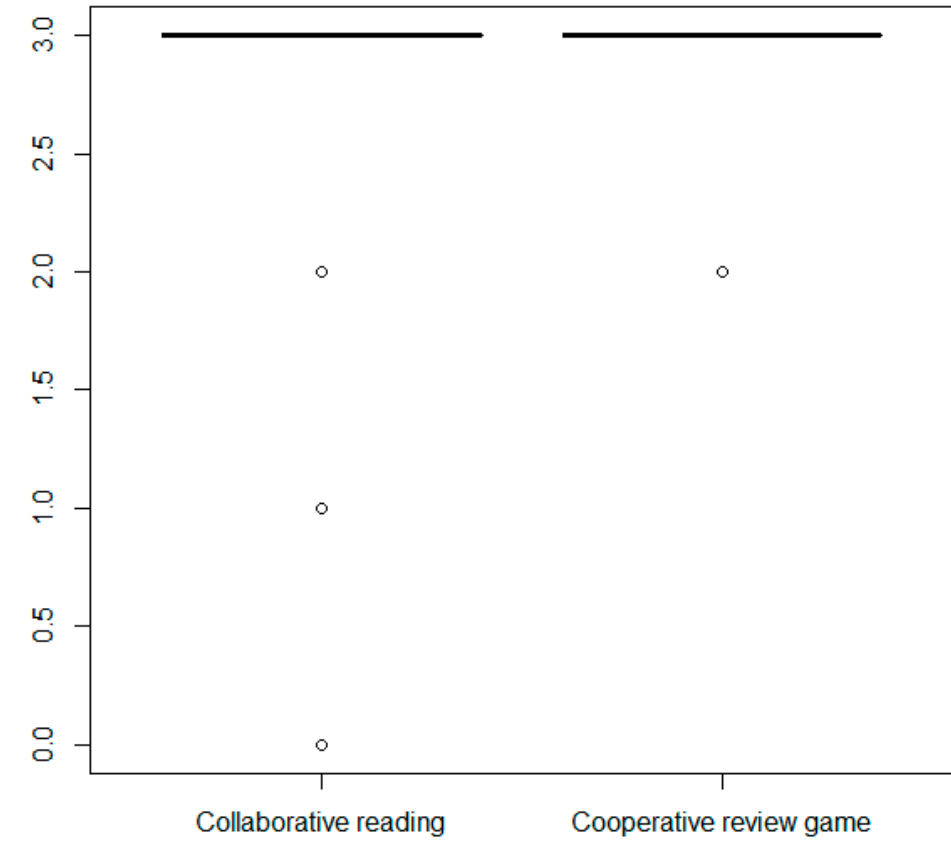
Figure 7. Responses to the question “Socrative seemed appropriate to work in small groups”.